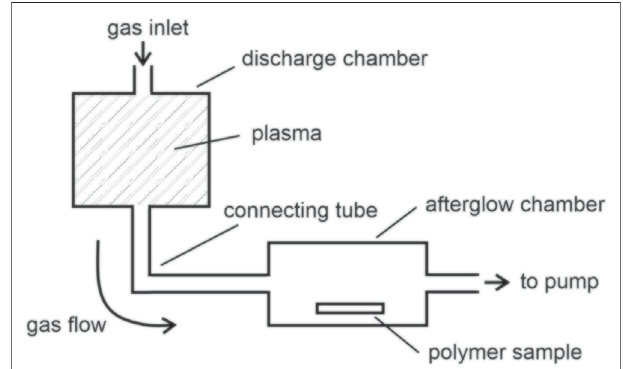
FIGURE 4 | Shematic of an experimental system for treating polymer samples with neutral reactive particles